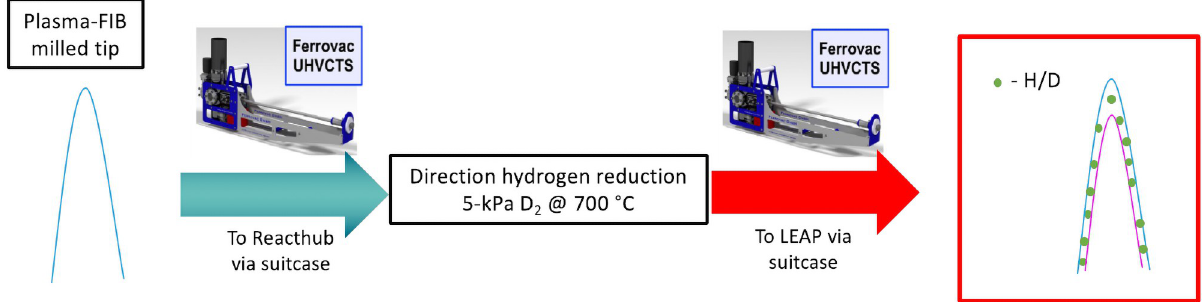
Fig 8. Reacthub protocol for hydrogen reduction. Workflow schematic for the direct hydrogen reduction of FeO employing deuterium gas.